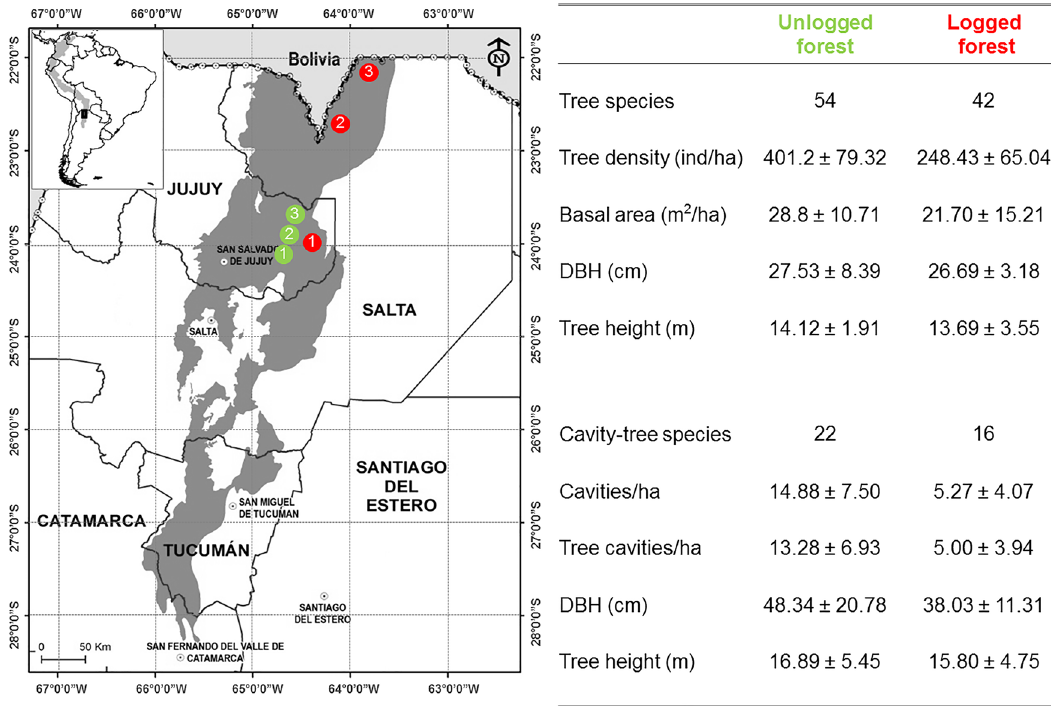
Figure 1. Location of the study sites in subtropical piedmont forests of northwestern Argentina: unlogged (green) and logged (red) forest sites are depicted on the map. Total tree species and habitat variables measured are also shown. This figure was produced using QGIS version 3.20.2 (https:// www. qgis.